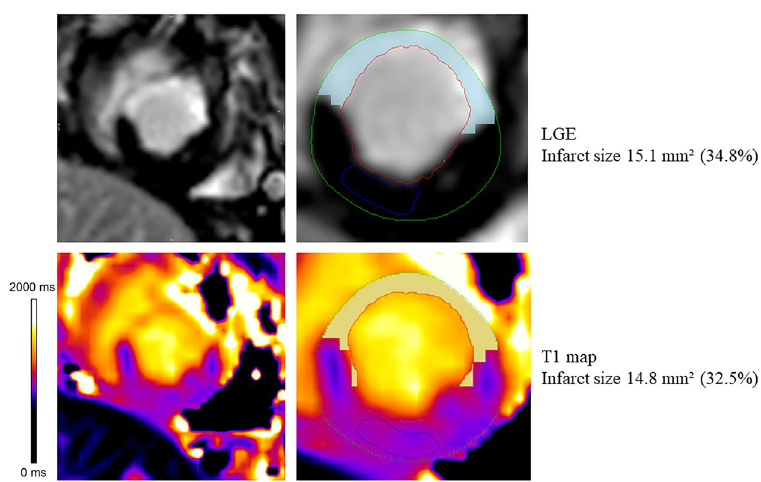
Figure 2. Infarct size analysis in a swine MI model at 1.5 T. Legend: Infarcted myocardium is identified on both images using the mean + 5 SD criterion for the LGE image and mean + 3 SD criterion for the T1 map (highlighted in blue and yellow pixels on the LGE image and T1 map) in respect to a reference region of interest drawn in the remote myocardium (blue contours). The infarcted area accounts for 32.5% and 34.8% of the entire myocardium of the slice on the T1 map and the LGE image